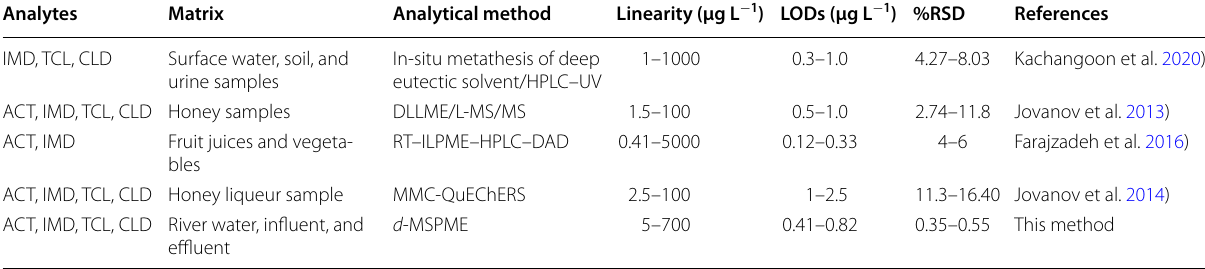
Table 5 Analytical characteristics of the proposed method in comparison with the recently reported methods for the extraction and determination of neonicotinoids in various matrices